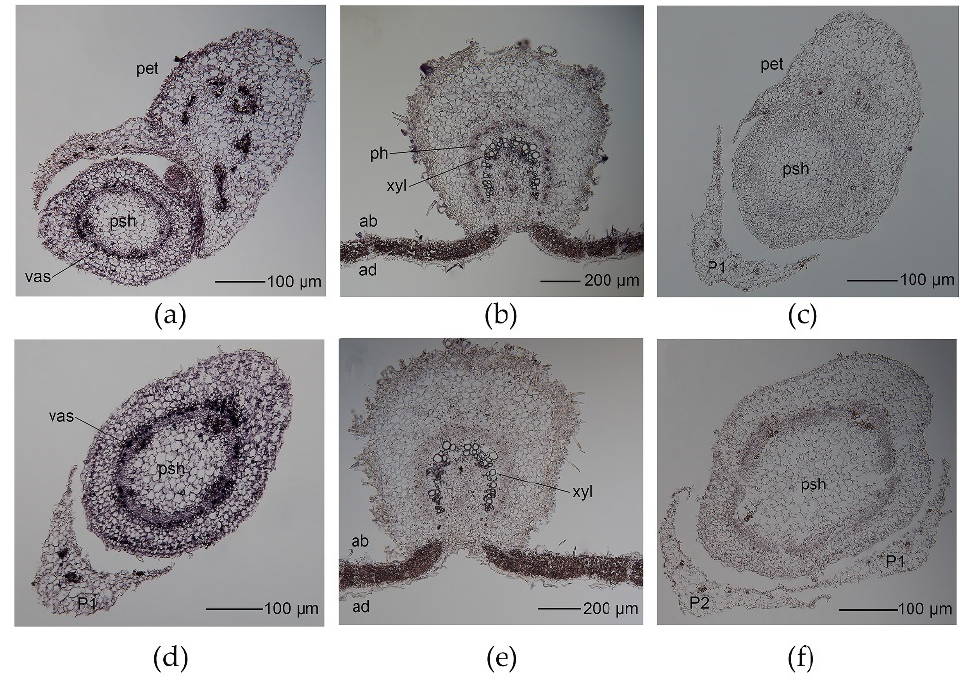
Figure 5. Expression patterns of BpYAB3 and BpYAB5 in the SAM and mature leaf by in situ hybrid- ization. ( a,b ) Expression patterns of BpYAB3 in the shoot apical meristem and mature leaf. ( c ) Sense probe for BpYAB3 as a negative control. ( d,e ) Expression patterns of BpYAB5 in the shoot apical meristem and mature leaf. ( f ) Sense probe for BpYAB5 as a negative control. Abbreviation: ab, abaxial; ad, adaxial; pet, petiole; psh, primary shoot; p, primordium; ph, phloem; vas, vascular bundle; xyl, xylem.